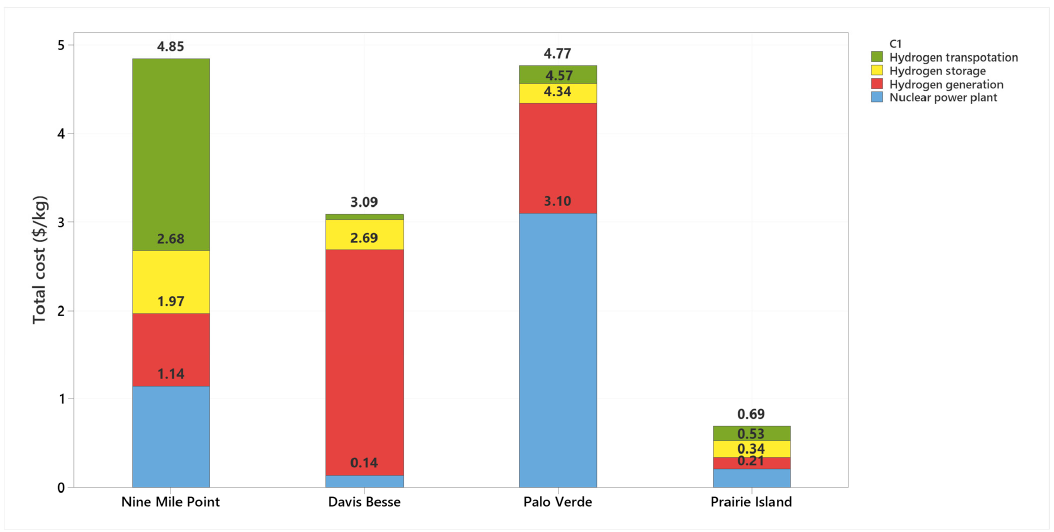
Figure 3. Cost of nuclear hydrogen production from four nuclear facilities in the